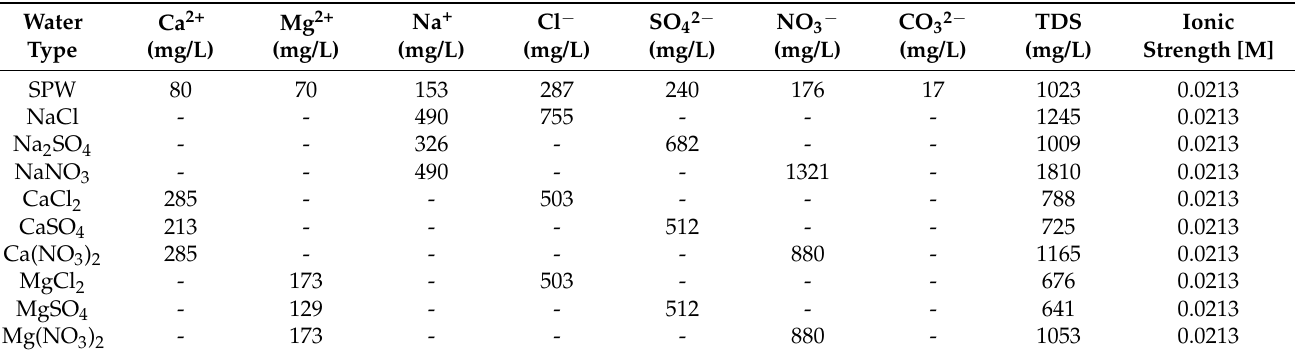
Table 1. Chemical compositions of synthetic plant water and the various single salt solutions tested in this